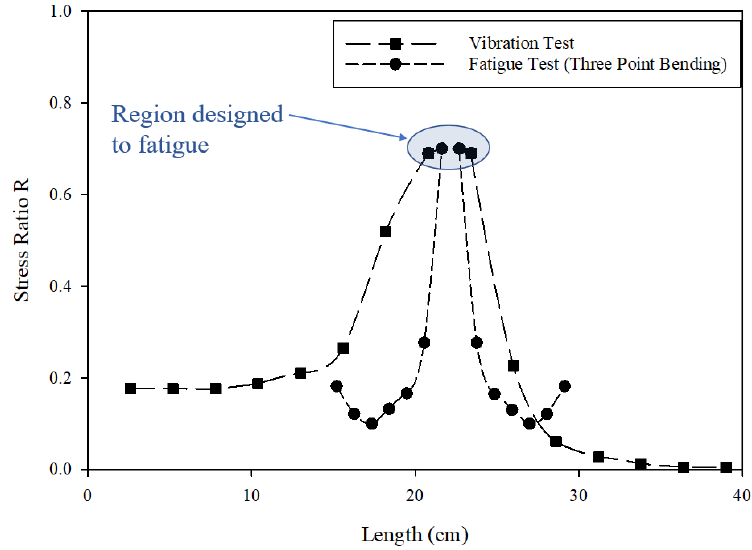
Figure 10. Comparison of the stress profiles obtained with Three-Point Bending and the final vibra- tion test specimen (final Von Mises design profile).